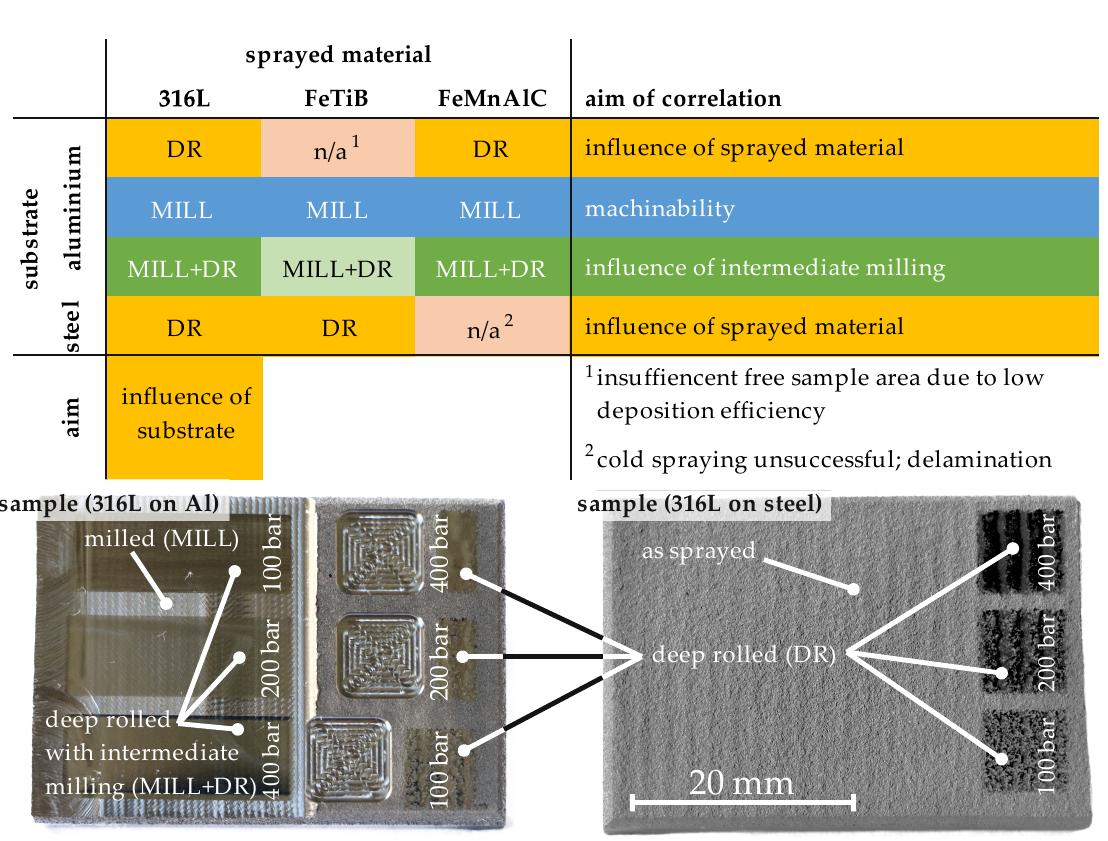
Figure 3. Schematic illustration of the experimental procedure.